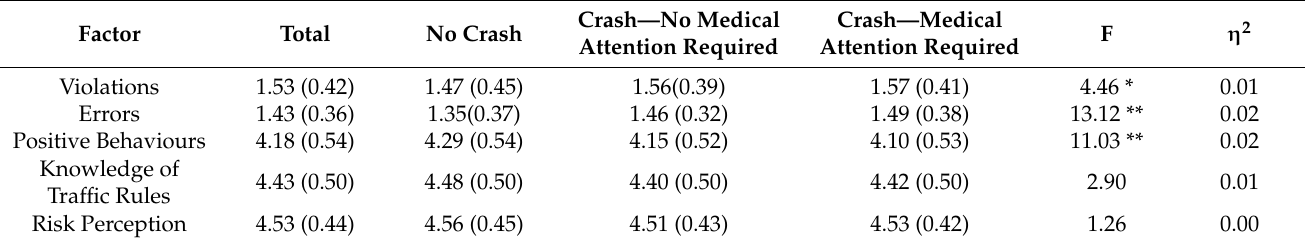
Table 4. MANCOVA of CBQ and RPRS factors and crash